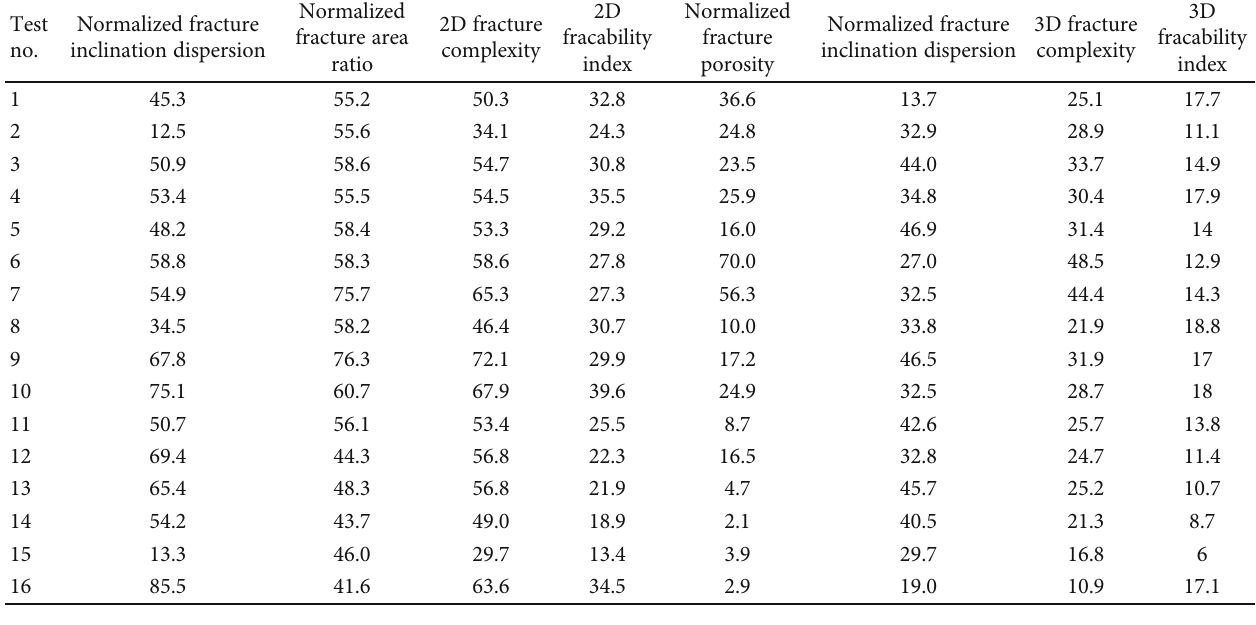
Table 3: Comparison of the 2D and 3D fracture complexity analysis results after the core being pressed. Test Normalized fracture no.